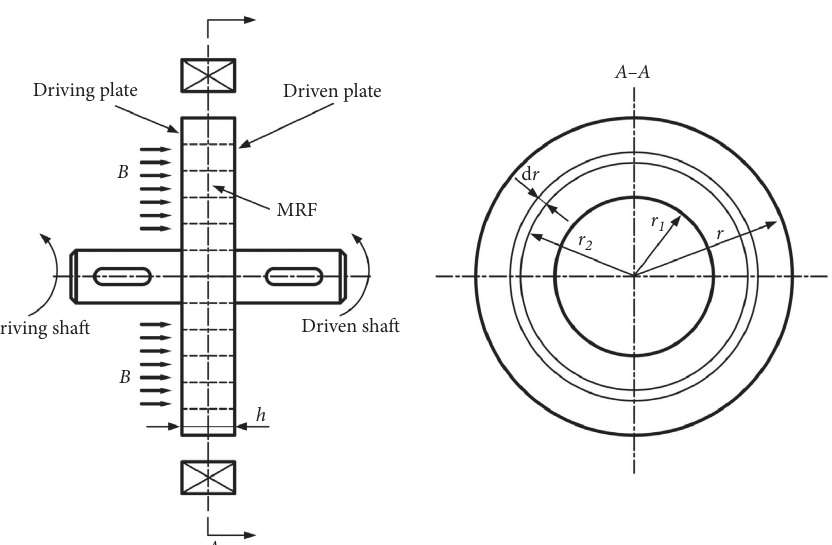
Figure 3: Working principle of MRF shear.